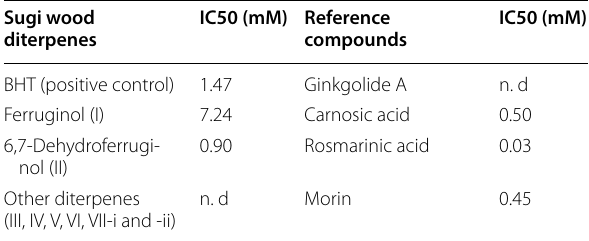
Table 1 IC50 of sugi wood diterpenes and